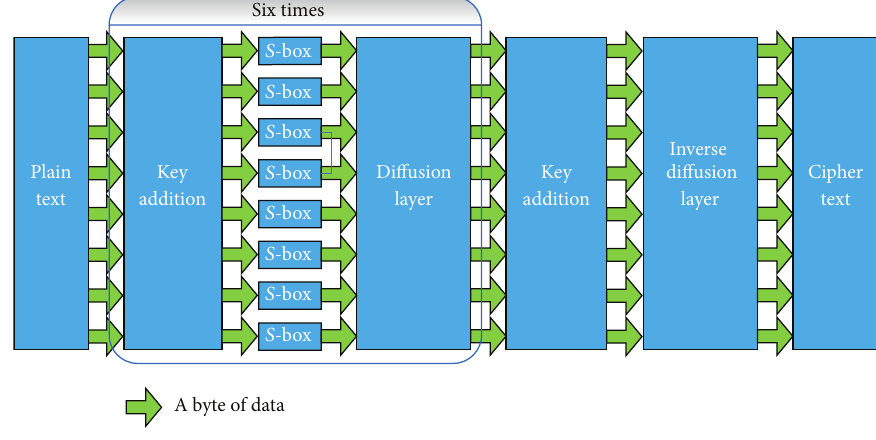
Figure 1: Flow of the SHARK